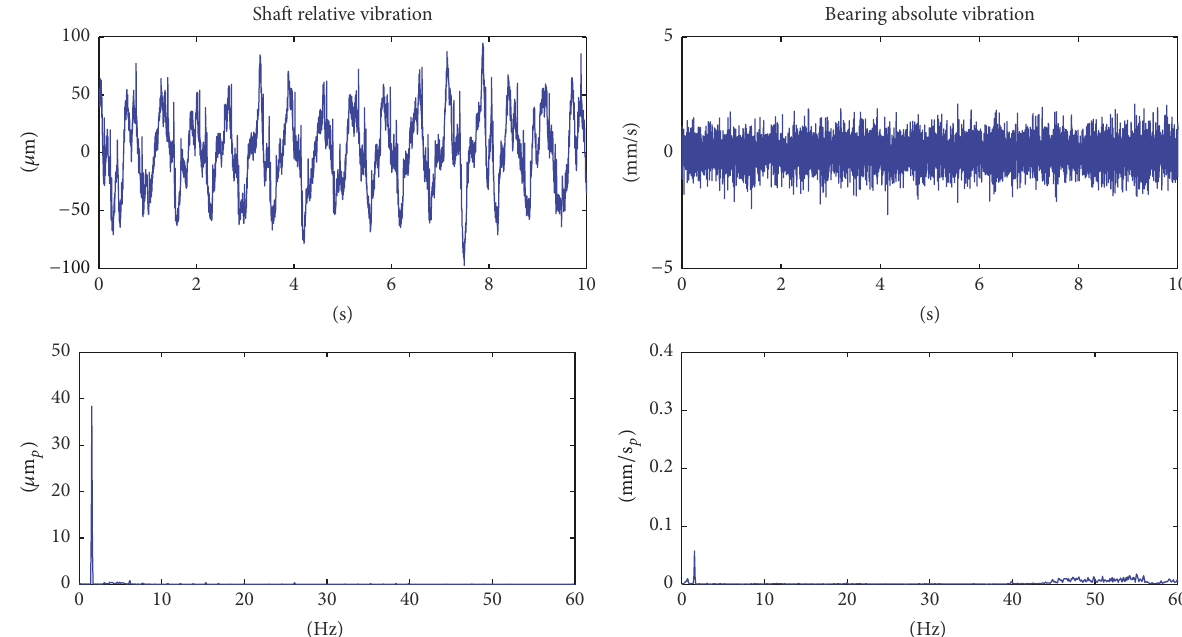
Figure 7: Shaft relative and bearing absolute vibrations at X -direction of the lower journal bearing when generator rotor had unbalance G4.25 at the relative time t 1 + 7.0 h.